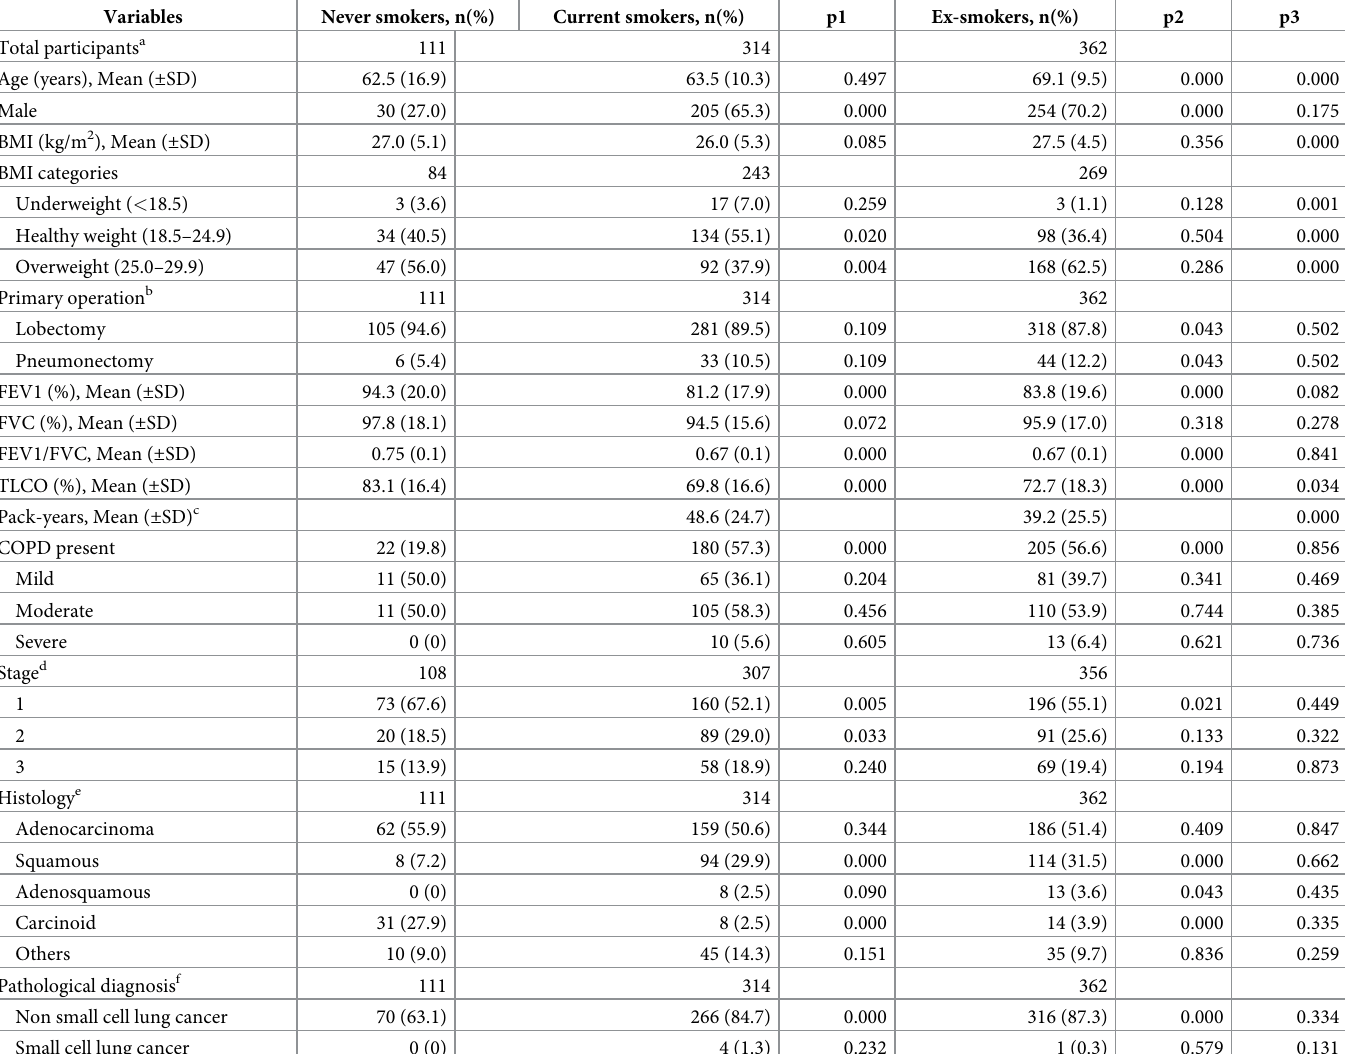
Table 1. Patient